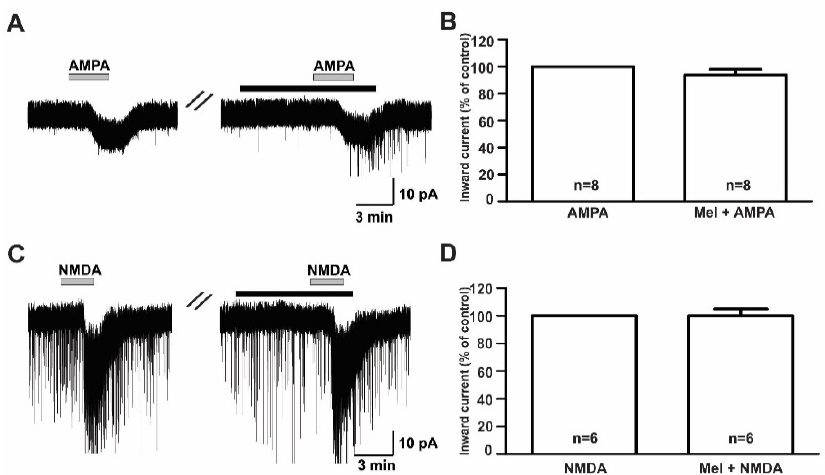
Figure 3. Effects of melatonin on α-amino-3-hydroxy-5-methyl-4-isoxazolepropionic acid (AMPA)- and N-methyl-D-aspartic acid (NMDA)-induced responses. ( A , C ) Representative traces showing inward currents induced by AMPA (10 µ M) and NMDA (30 µ M) in the absence and the presence of 10 µ M melatonin. The black bars represent the duration of the melatonin application. ( B , D ) Bar graphs showing the mean relative percentage of inward currents induced by AMPA and NMDA in the absence and the presence of 10 µ M melatonin ( p > 0.05; paired t -test). n , the number of neurons tested; Mel, melatonin.